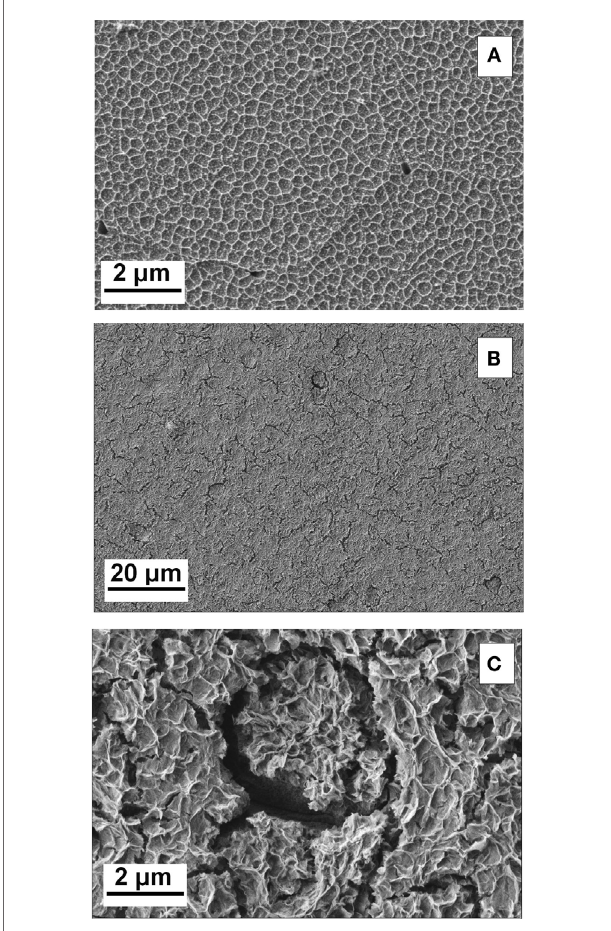
FigUre 1 | (a–c) SEM images of surface; (a) sample after pre-treatment; (B) sample after ultrasound-assisted surface film formation and (c) higher magnification of the surface